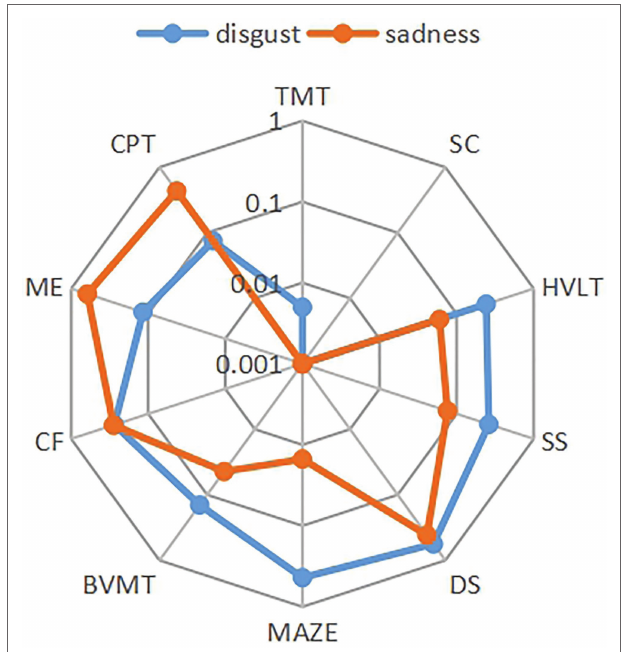
FIGURE 5 | Relationship between the expressions of disgust and sadness and cognitive